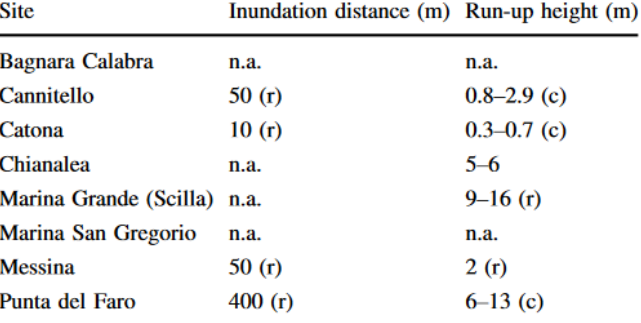
Figure 4. Inundation distance and run-up height in some of the locations along the coast. (r) Historically reported, (c) Computed from the reported inundation distance (Gerardi et al. 2008), (n.a.) data not available (Mazzanti and Bozzano, 2011).